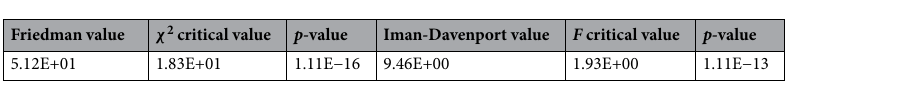
Table 4. Friedman and Iman-Davenport test results ( α = 0.05 ).